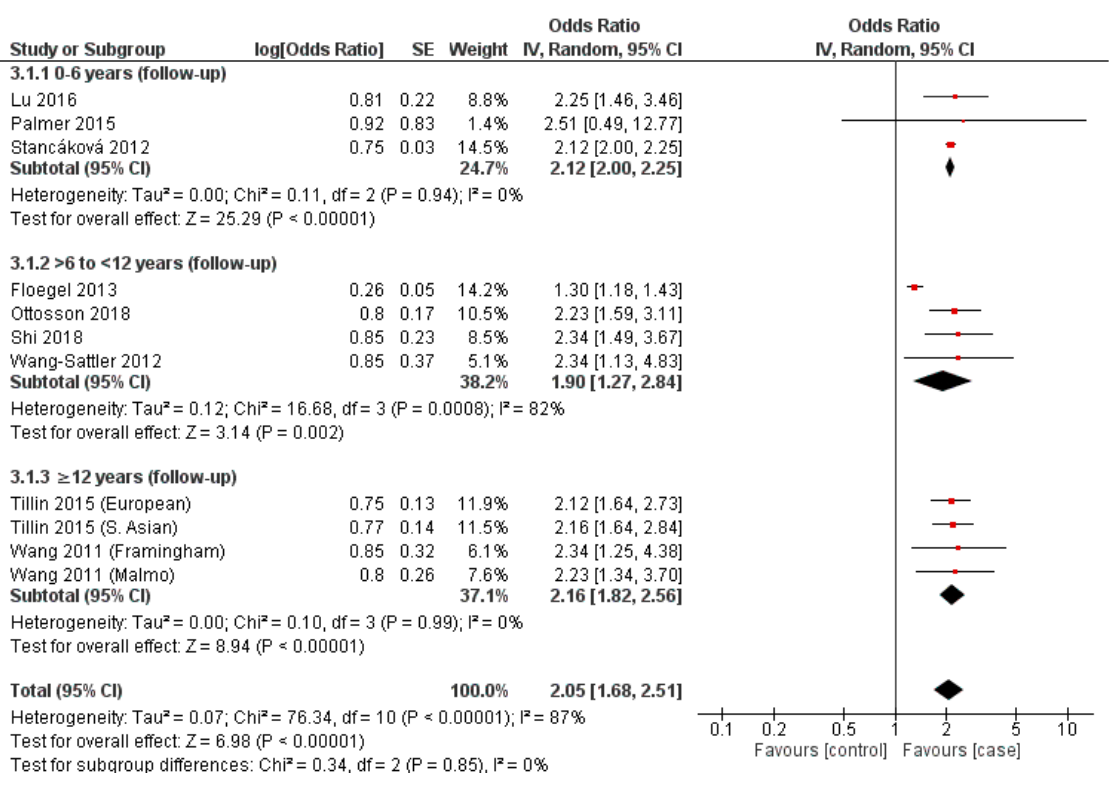
Figure 3. Forest plot depicting the effect sizes of the individual studies for isoleucine in each of the designated temporal subgroups [29–31,41–46].